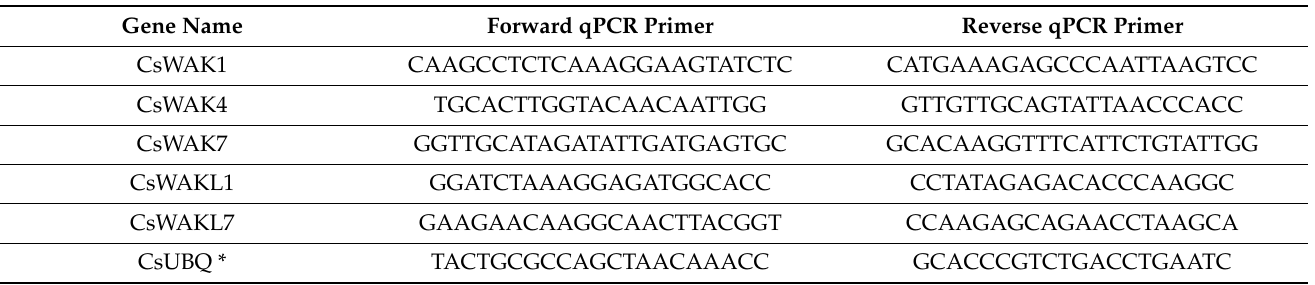
Table 3. qPCR primers